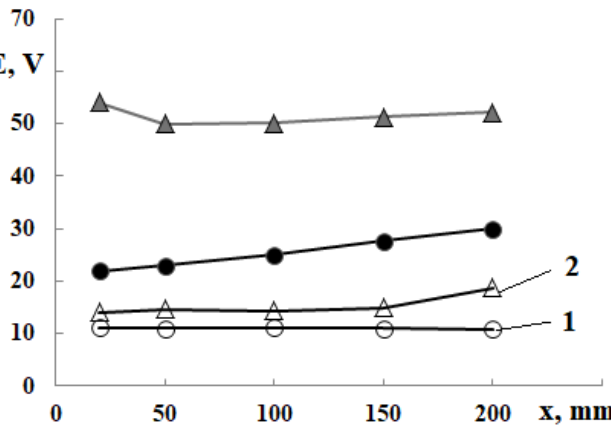
Figure 8. The electric field strength in the operating reactor when working with: 1—zeolites and 2—clay. White dots—after starting the reactor, dark—after 30 min of the start. The airflow through the plasma torch was 1 g/s, and the additional gas flow rate was 2.63 g/s. The PT power was 41 kW.